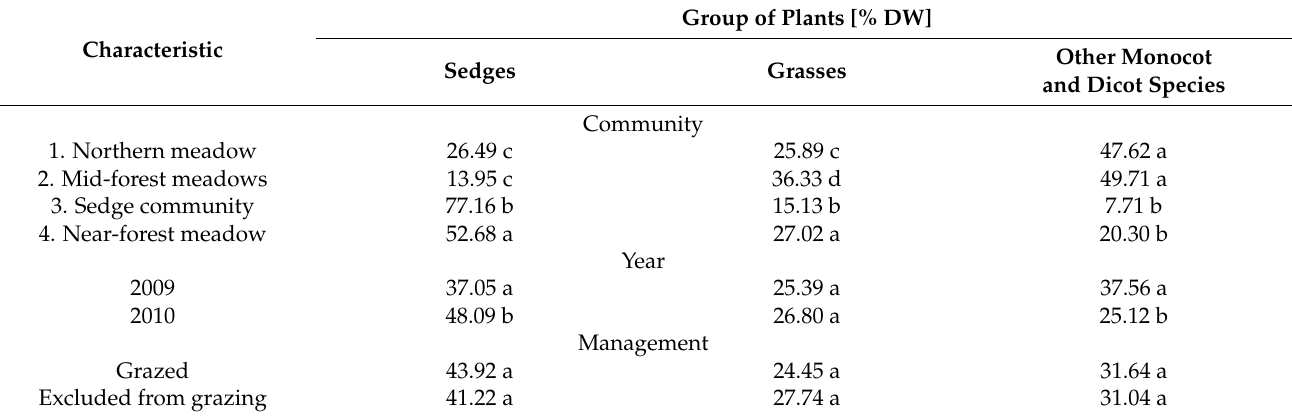
Table 5. Botanical composition of the sward [% DW] in selected grassland